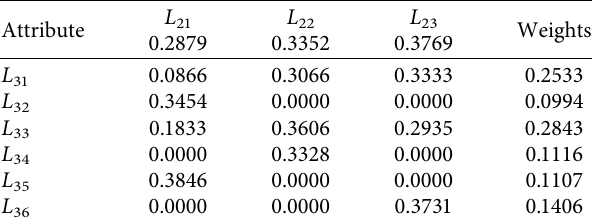
Table 1: Weights based on intuitionistic fuzzy AHP ( g )